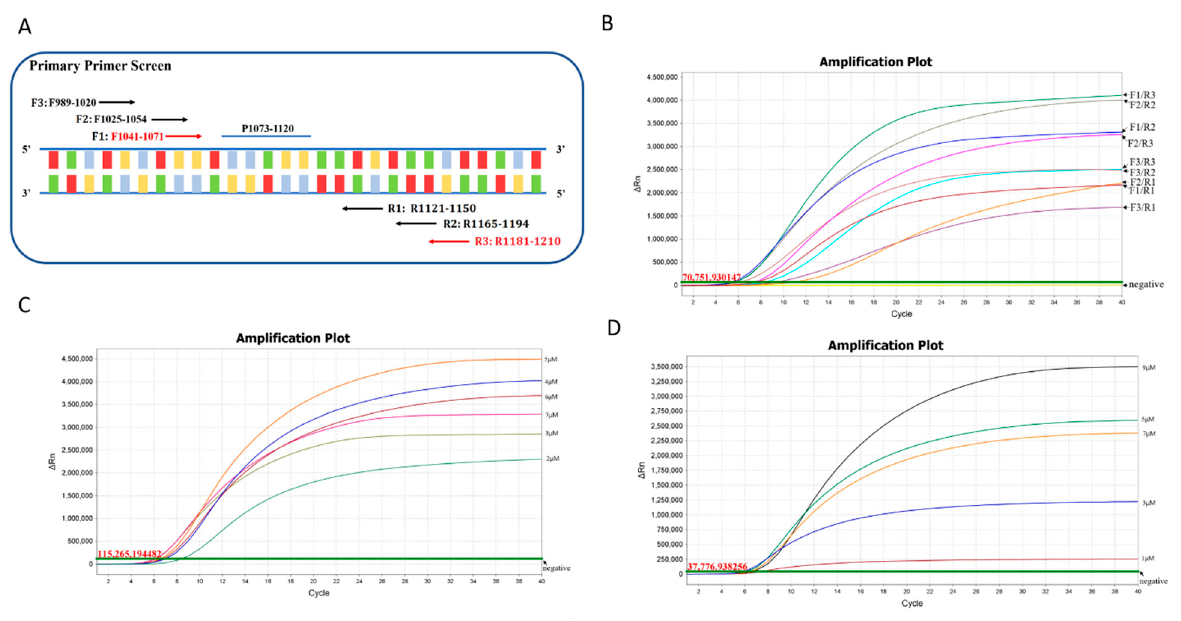
Figure 2. Reaction optimization for real-time RAA assays. ( A ) Schematic diagram of the primary primer screening. The numbers in the primer name represent the position of the oligonucleotides in the mecA gene of the N315 strain. ( B ) Representative amplification outcomes of real-time RAA in the primer pairs screening. All nine candidate primer pairs (F1/R3–F3/R3) were screened with the fixed amplification parameters. Three forward and three reverse candidate primers surrounding the probe p1073–1120 are indicated. ( C ) Optimization of the primer pair concentration for the real-time RAA assay. The amplification curves of different colors correspond to the concentrations of the primer pairs stock solution added in the reaction, including 2 μ M, 3 μ M, 4 μ M, 5 μ M, 6 μ M, and 7 μ M, respectively. ( D ) Optimization of the probe concentration for the real-time RAA assay. The amplification curves of different colors correspond to the concentration of the RAA probe stock solution added in the reaction, including 1 μ M, 3 μ M, 5 μ M, 7 μ M, and 9 μ M, respectively. Table 1. Sequences of primers and probes for MRSA real-time RAA and qPCR.